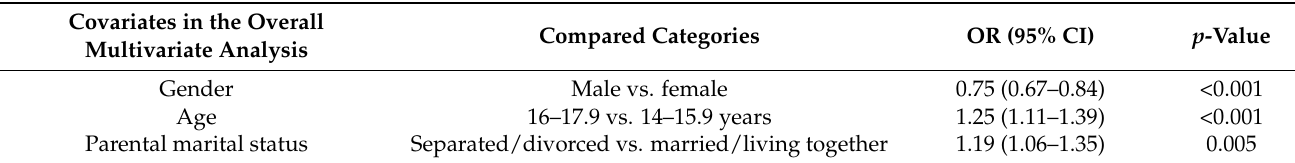
Table 3. Odds ratios (OR) and 95% confidence intervals (Cl) for covariates assessed in the complex samples, multivariate logistic regression analysis examining the association between cyberbullying victimization, and overweight/obesity in all